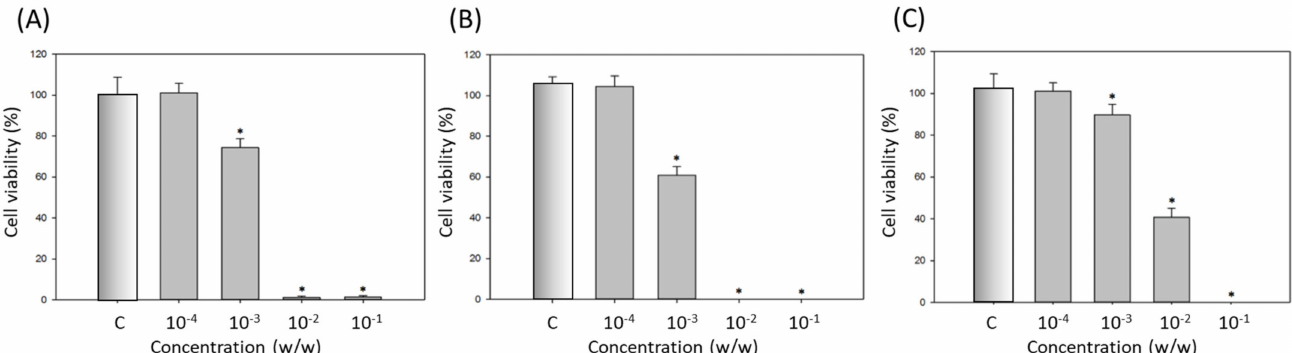
Figure 6. Cell viability of B16-F10 cells exposed to the microemulsions: ( A ) ME-20-dA; ( B ) ME-40-dA; ( C ) ME-80-dA. C: control group. Data are presented as means ± SE ( n = 3); * indicates a p value of less than 0.05 when compared with the